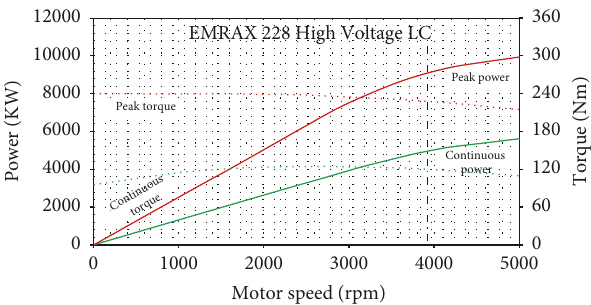
Figure 10: Motor characteristic curve.